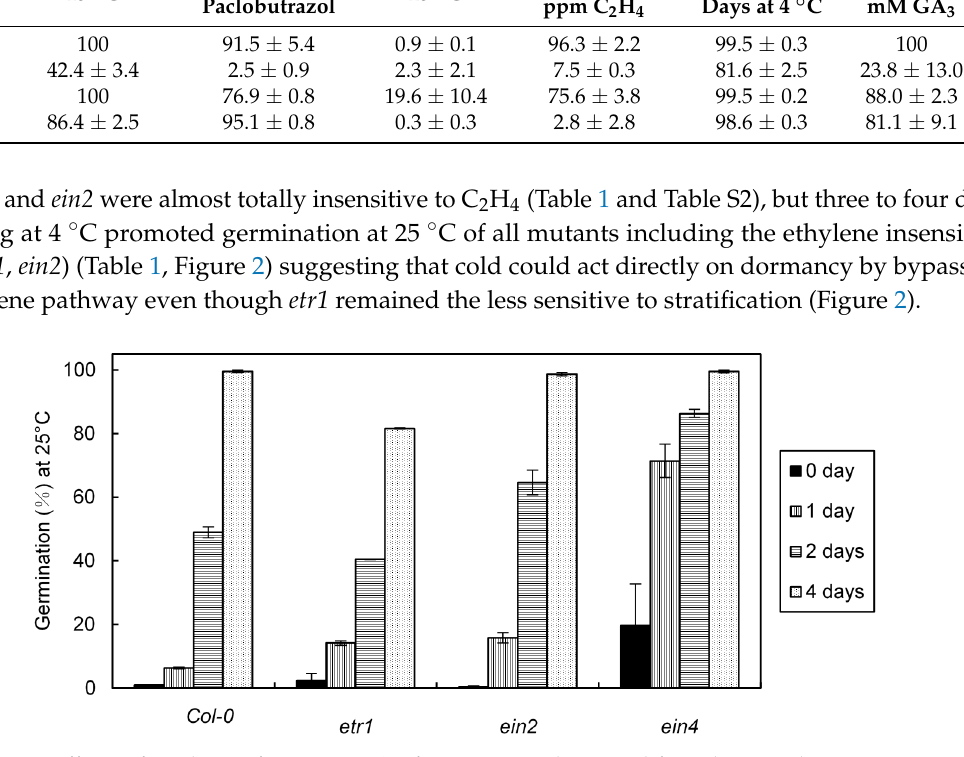
Figure 2. Effects of seed stratification at 4 °C for one, two, three, and four days on the germination percentages obtained after seven days at 25 °C with various genotypes affected in the ethylene signaling pathway ( etr1 , ein2 and ein4 ). Means of three replicates ± SD.